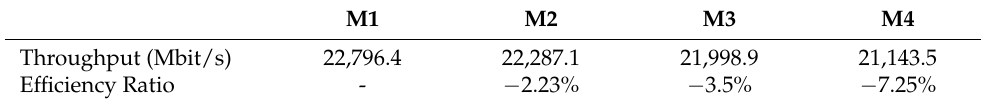
Table 9. Encryption throughout (Mbit/s) of Strike over different machines.